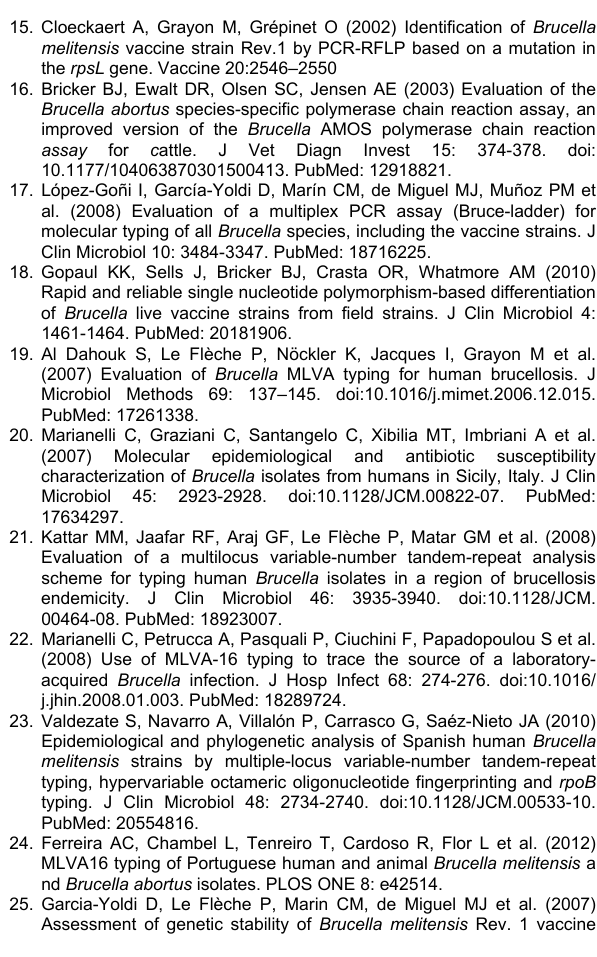
Table S1. MLVA-16 genotypes for all Brucella isolates. The coding convention for in silico MLVA typing of reference